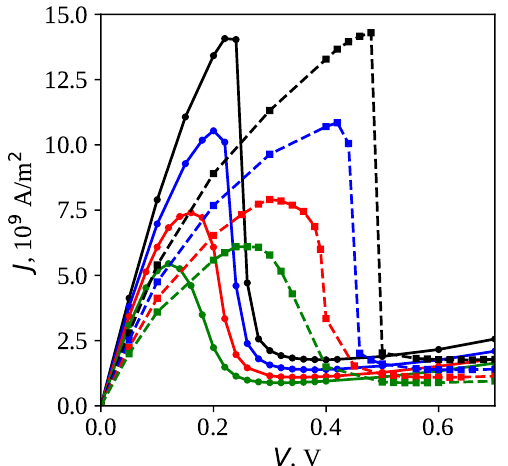
Figure 9. Current–voltage characteristics of the RTD Structure #2 at various emitter spacer thicknesses: L SE = 2 nm—black lines, L SE = 4 nm—blue lines, L SE = 6 nm—red lines, L SE = 8 nm—green lines. Solid lines correspond to L SC = 10 nm, and dashed lines correspond to L SC = 20